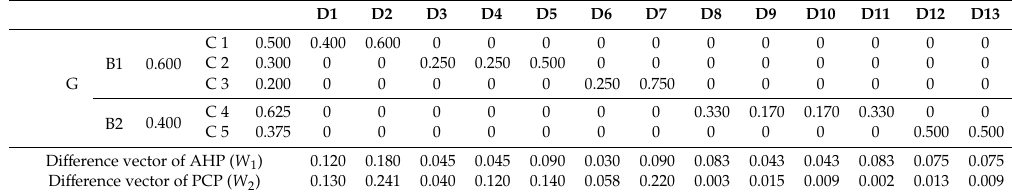
Table 3. Weight index evaluation of the analytic hierarchy process (AHP) and the principal component projection (PCP).